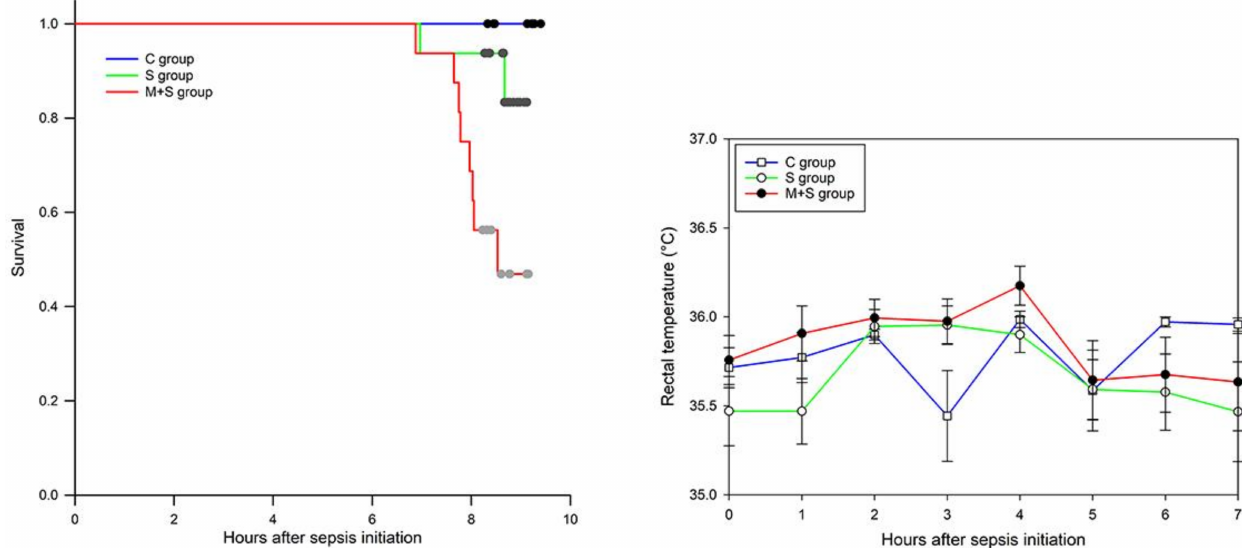
Figure 1. Survival rate analysis (left) and time-course curve of rectal temperature recordings (right) in rats of control (C), sepsis (S), and meldonium + sepsis (M + S) groups. The data on the rectal temperature recordings are given as time-points mean ± standard